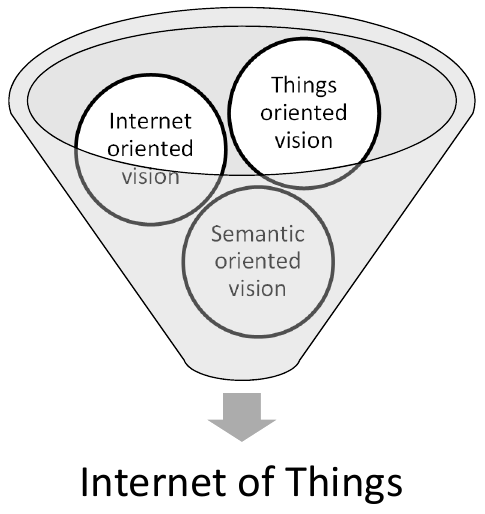
Figure 2. IoT Figure 2. IoT visions.